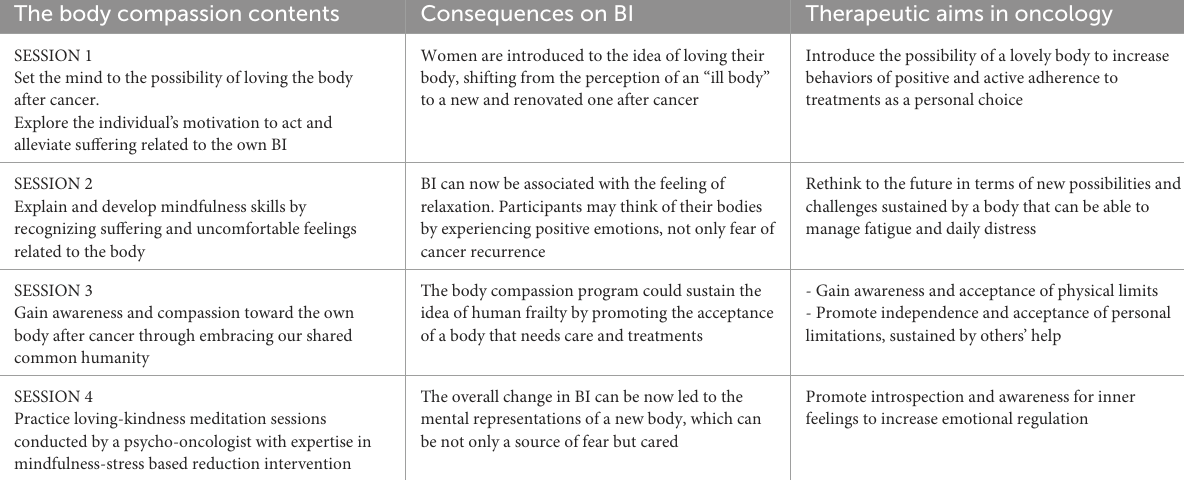
TABLE 1 Sessions of the body compassion intervention on BI. The body compassion contents Consequences on BI Therapeutic aims in